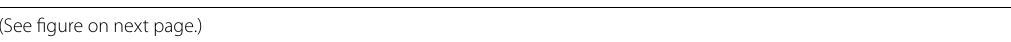
Isepponi(See figure on next Fig. 14 A Aerial view of the Reichenau breach. White line with tick marks outlines the erosional scarp. Photo ©VBS. B Aerial view of the Tuma landscape of Domat/Ems. Note the large fans built up from tributaries on the right (south) that deviate the Rhine to the left. These fans existed already at the time of the Flims events such that the Bonaduz mass flow was also constrained to the left side of the valley floor. Photo R. Homberger, courtesy of F.